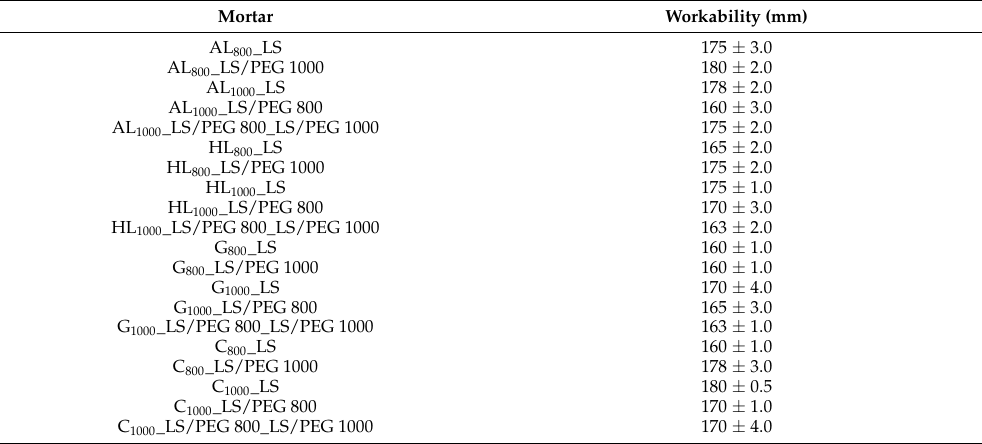
Table 2. Workability values of the mortars whose compositions are reported in Table 1.